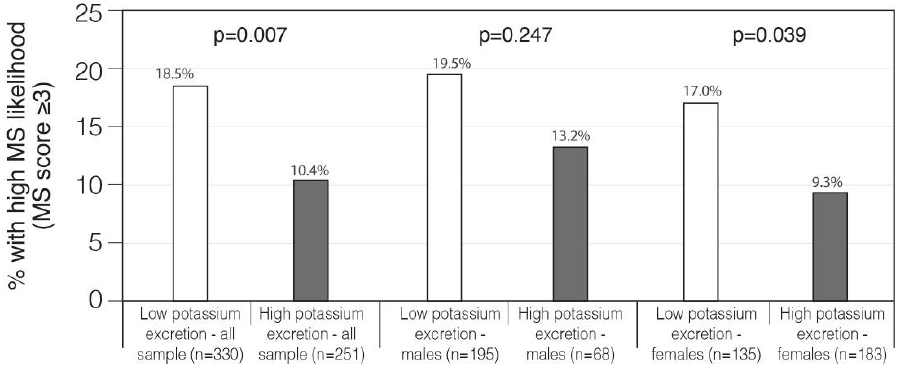
Figure 1. MS-likelihood prevalence according to potassium excretion levels in the total sample and gender-stratified. 24-h potassium excretion was normalized for 24 h creatinine excretion (mg). Potassium exposure levels are based on mean levels ( ≥ 2.27 was defined as high potassium excretion vs. <2.27 defined as low potassium excretion). MS-likelihood rates were compared using Chi- square-test. Table 3. Pearson and Spearman correlation coefficients of electrolytes variables and other potential explanatory variables for the metabolic syndrome as well as its components.